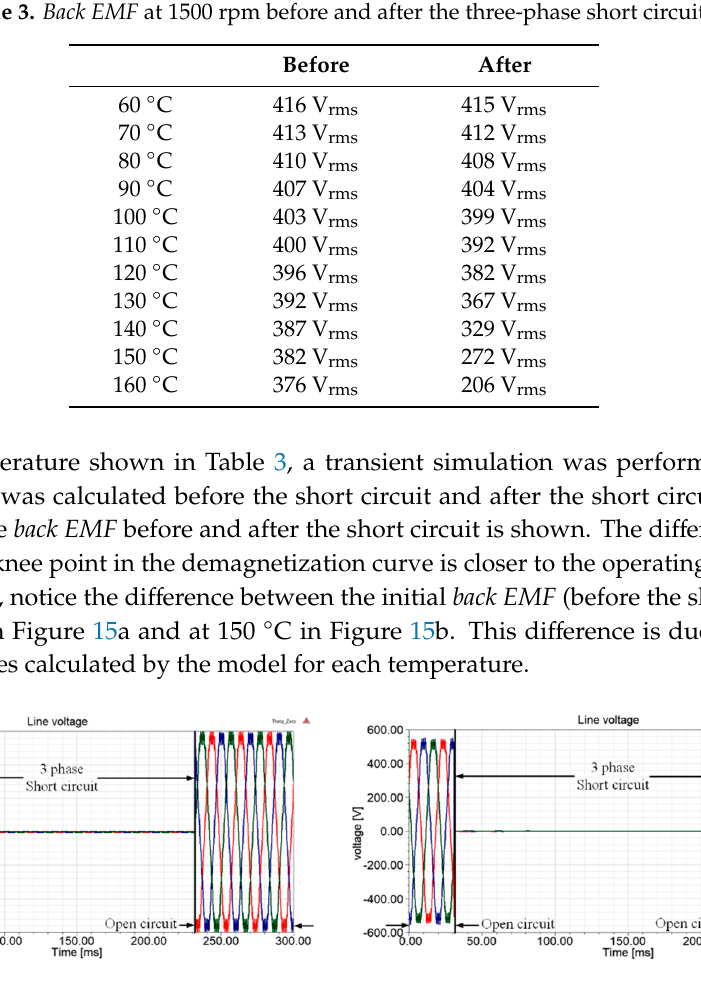
Table 3. Back EMF at 1500 rpm before and after the three-phase short circuit. Before After